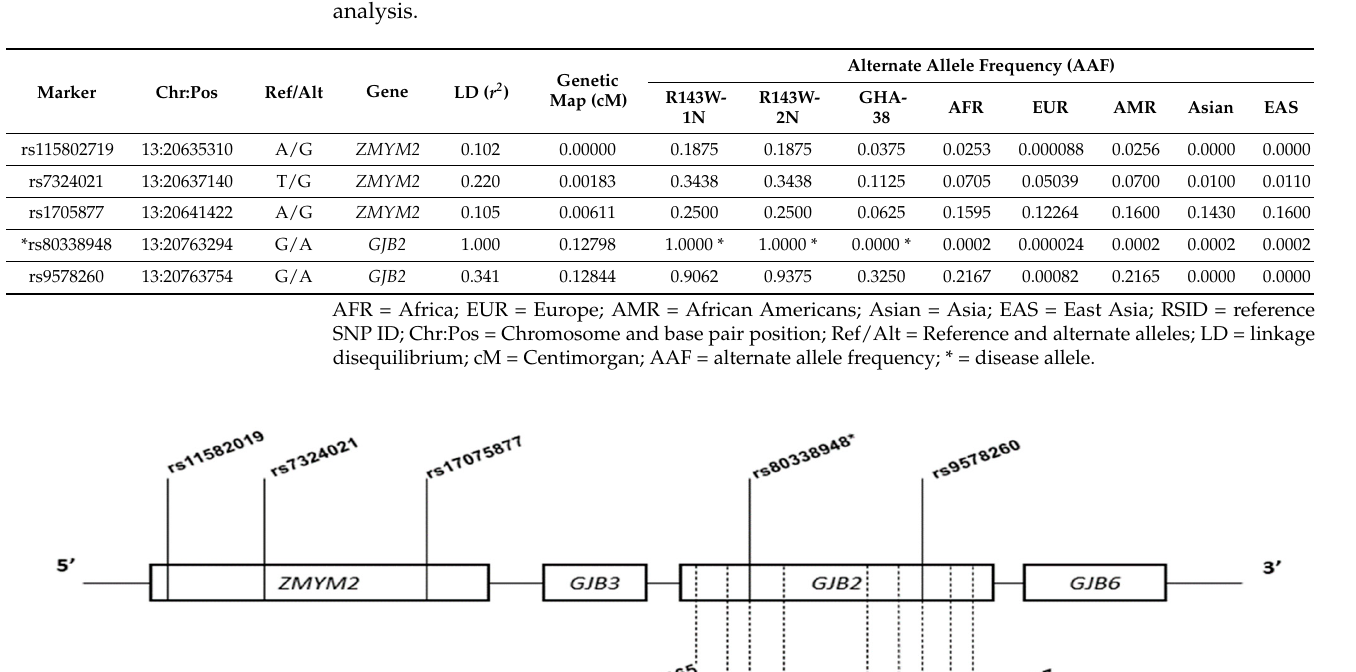
Table 1. Features of linkage disequilibrium ‐ selected variants for the age estimate and haplotype analysis.